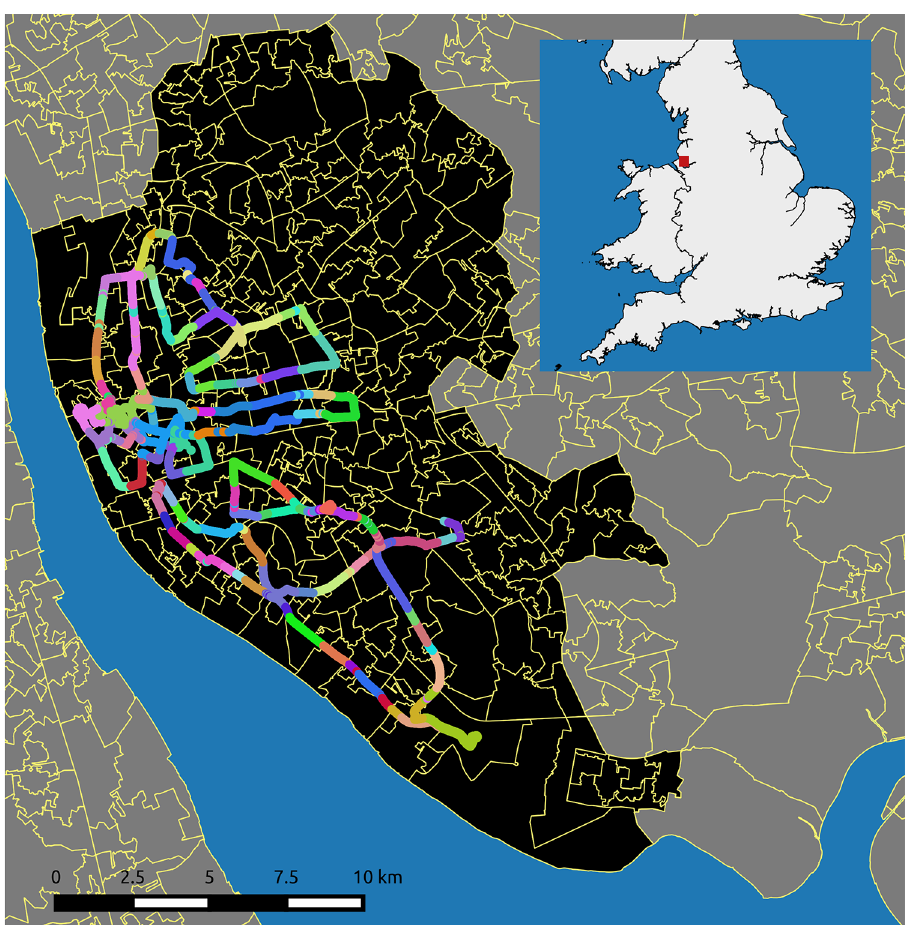
Figure 1. Map depicting the coverage of the LIV360SV dataset color coded by lower-layer super output areas (LSOAs). This map was created using QGIS 2.8.6-Wien 39